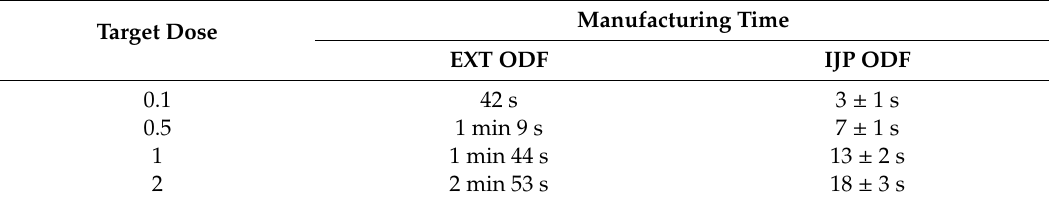
Table 4. Manufacturing times for EXT ODFs and IJP ODFs. The manufacturing time includes the